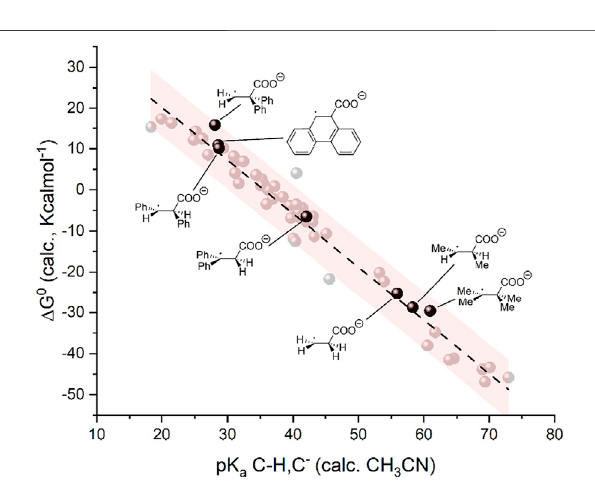
FIGURE 5 | Plot of calculated standard free energy of carboxylation ( Δ G 0 1 )vs.calculatedpK a oftheCH/C − couples. Thetwoblackdotsrefertothe products upon carboxylation in α position to the carbonyl from fl avone and chalcone anions F(A) and C(A) . The light gray dots indicate the same 50